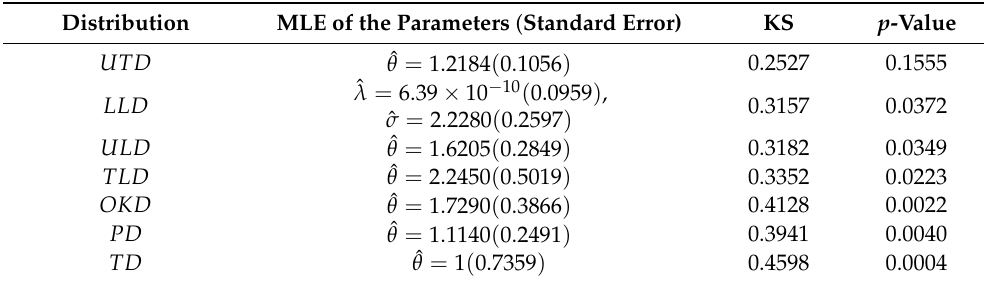
Table 7. The MLEs of the parameters with their standard errors, KS values, and the associated p